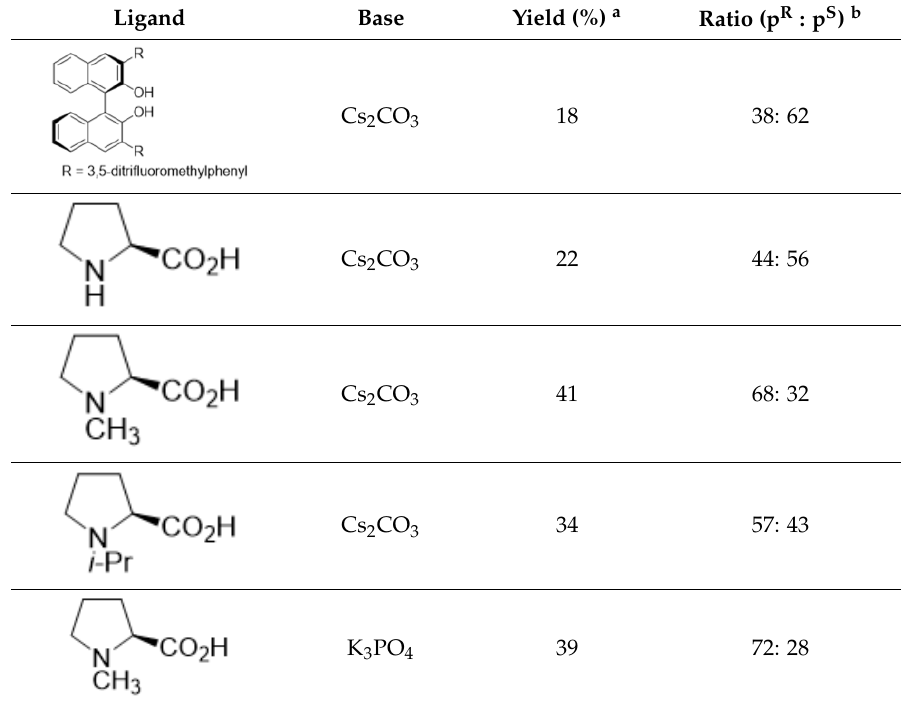
Table 7. Optimization of reaction conditions.